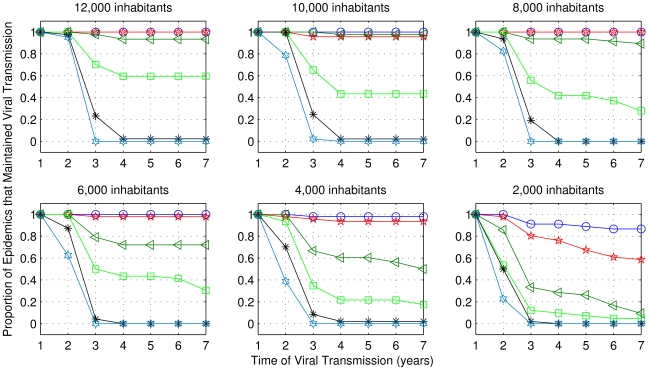
As in
Figure 12
, considering 1.5 bites per day.